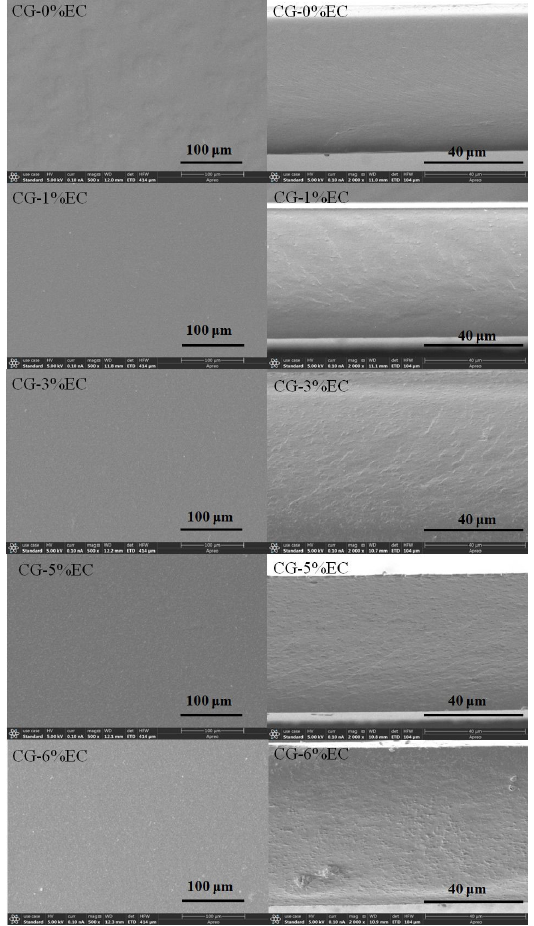
Figure 2. SEM micrographs of surface ( Left ) and cross ‐ section ( Right ) of CG/EC films.